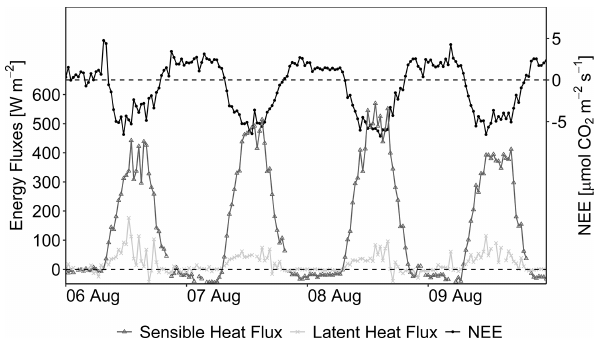
Figure 12. Daily cycles of 30min sensible and latent heat fluxes and NEE fluxes during a rainless period in midsummer, from 6 to 9 Au- gust 2018, when these fluxes originated from the eucalypt patches.